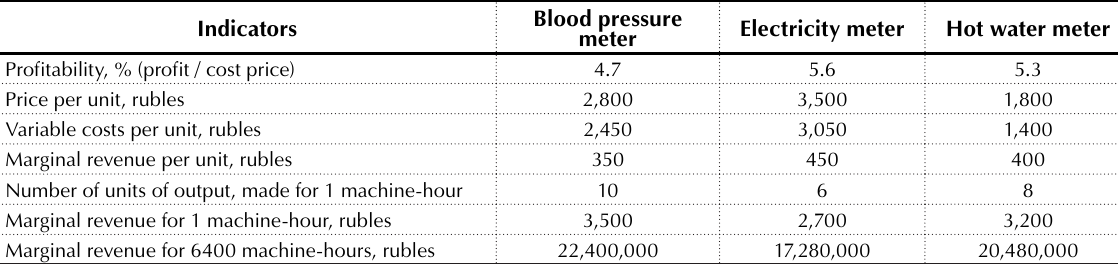
Table 1. Analysis of management decisions on the range of products